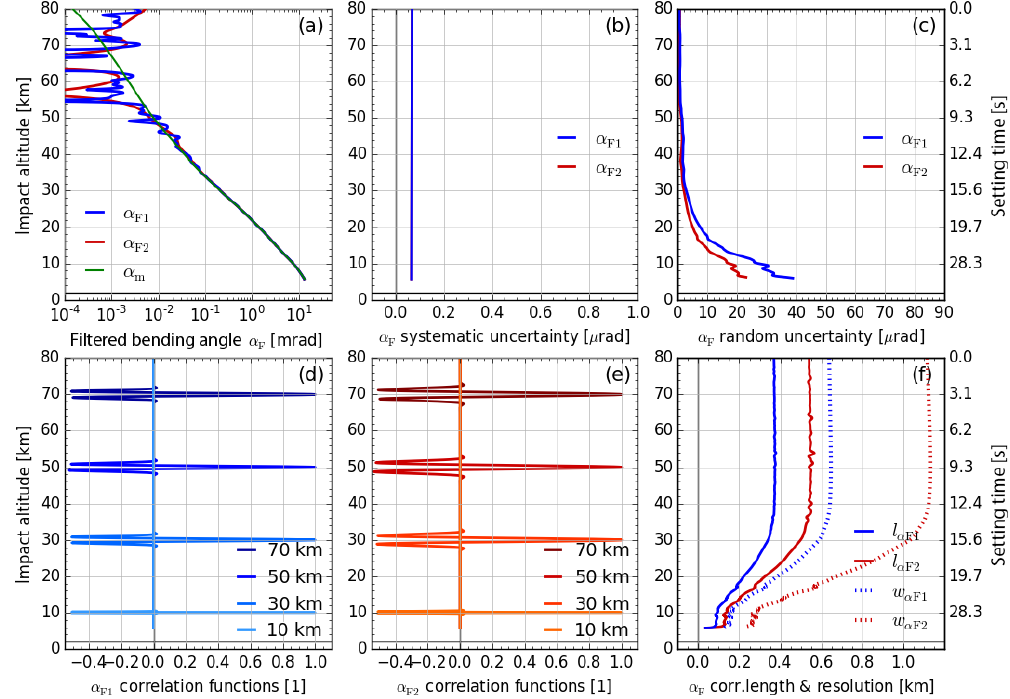
Figure 7. Results for filtered bending angle profiles α F (with model profile α m for comparison) in panel (a) , systematic uncertainty profiles u s in panel (b) , random uncertainty profiles u r in panel (c) , representative correlation functions R α F ,i (at 10, 30, 50, and 70km) in α F α F panels (d) and (e) , and correlation length l α F (solid) and resolution profiles w α F (dotted, estimated for main peak) in panel (f) . All profiles are shown for both GPS carrier frequencies: f T1 (blue) and f T2